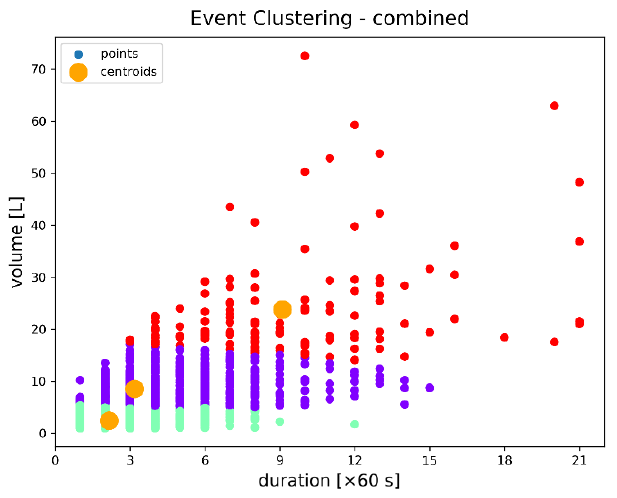
Figure 11. Consumption event clustering — combined.